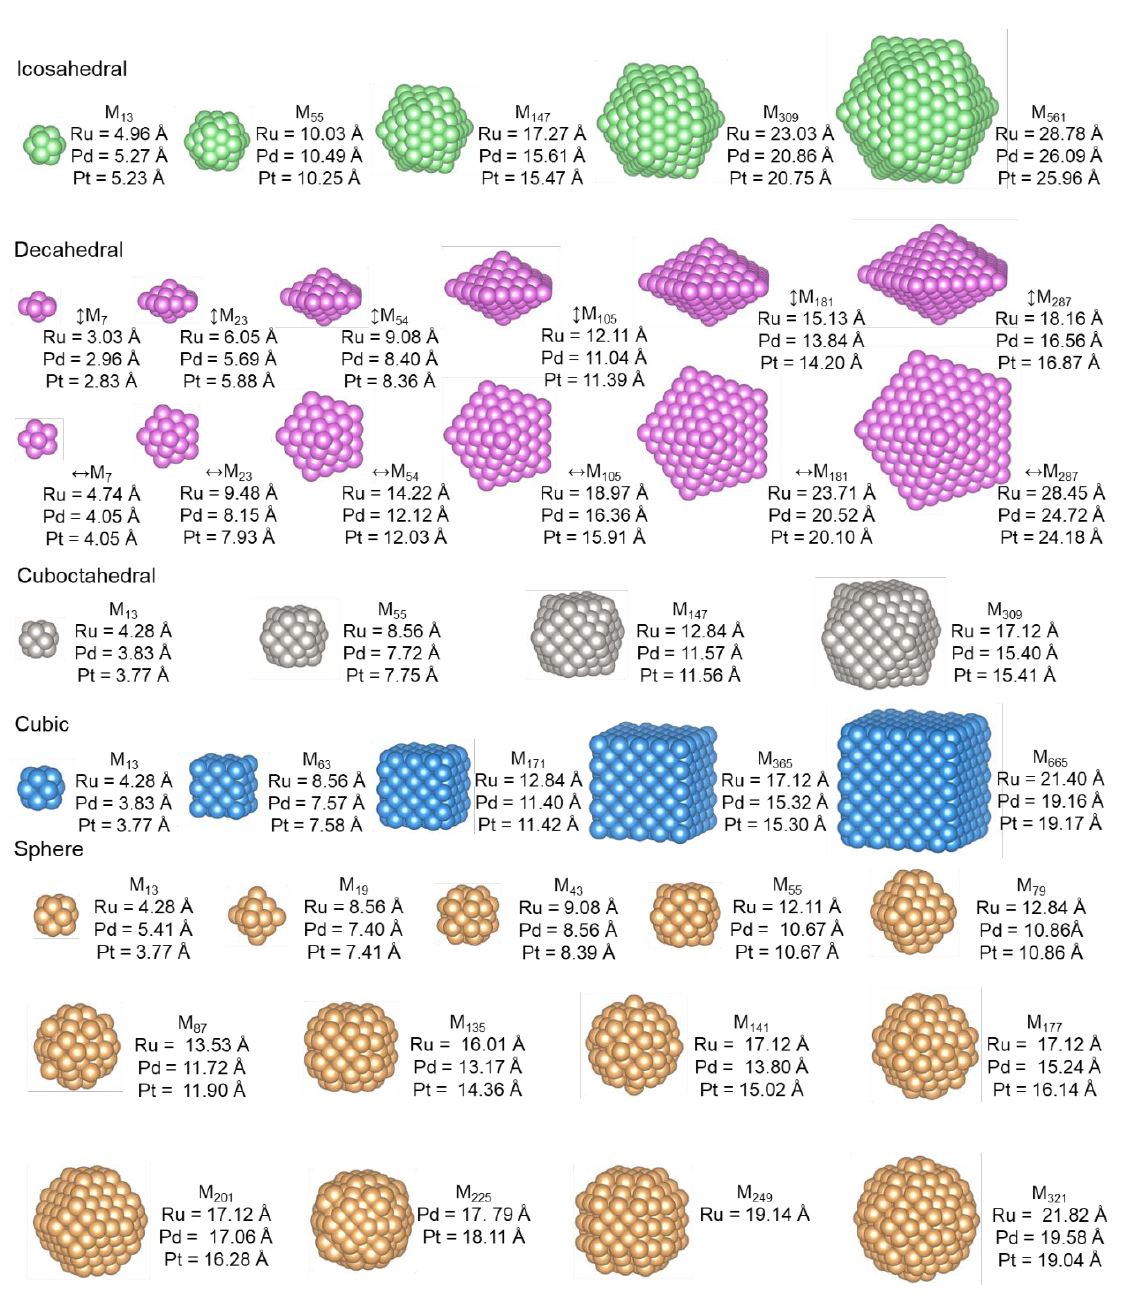
Figure 2. Various sizes and shapes of the stable fcc nanostructures for Ru, Pd and Pt, including icosahedral, decahedral, cuboctrahedral, cubic and spherical particles.